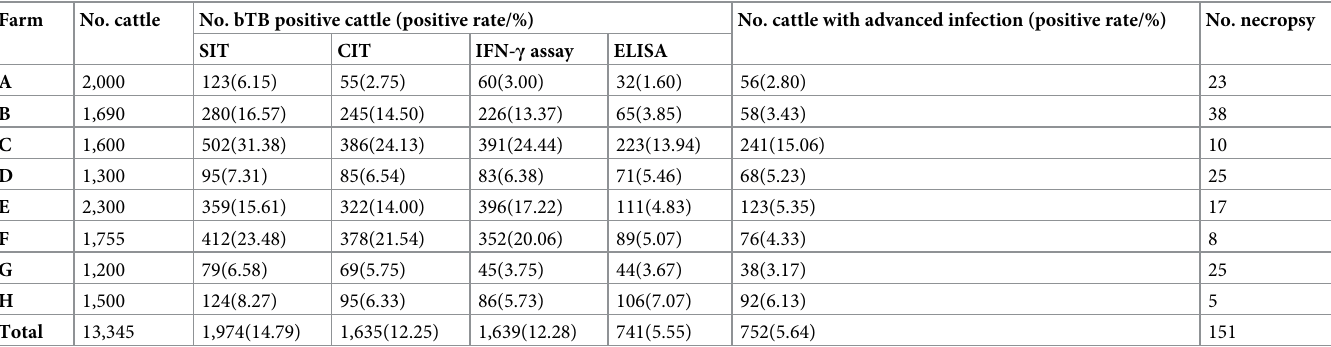
Table 1. Results of immunological